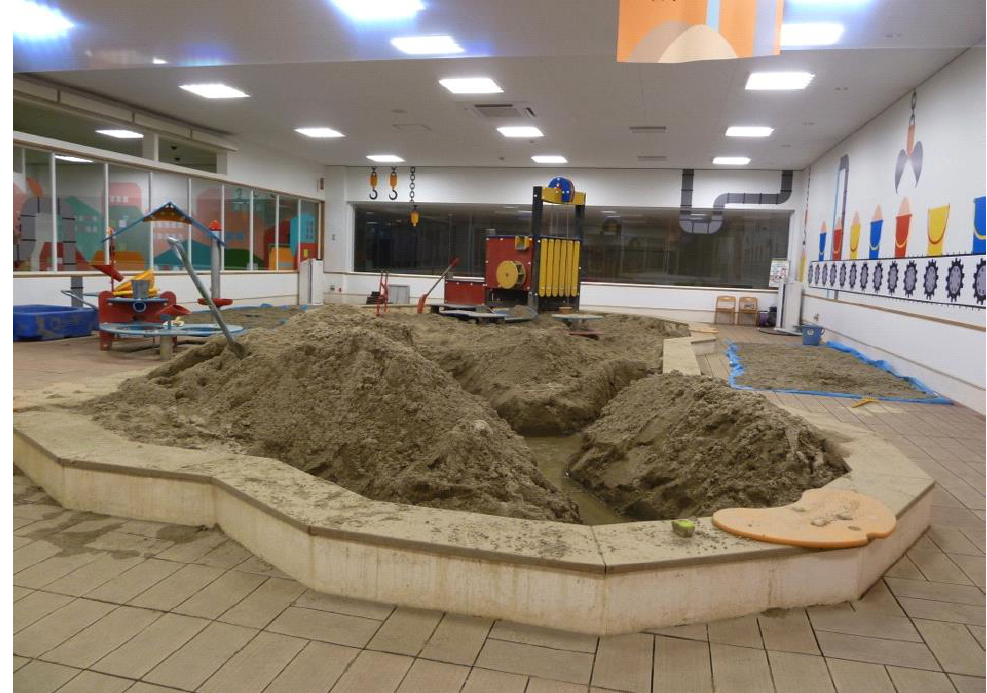
Figure 6. Indoor playground “PEP Kids” in Kooriyama